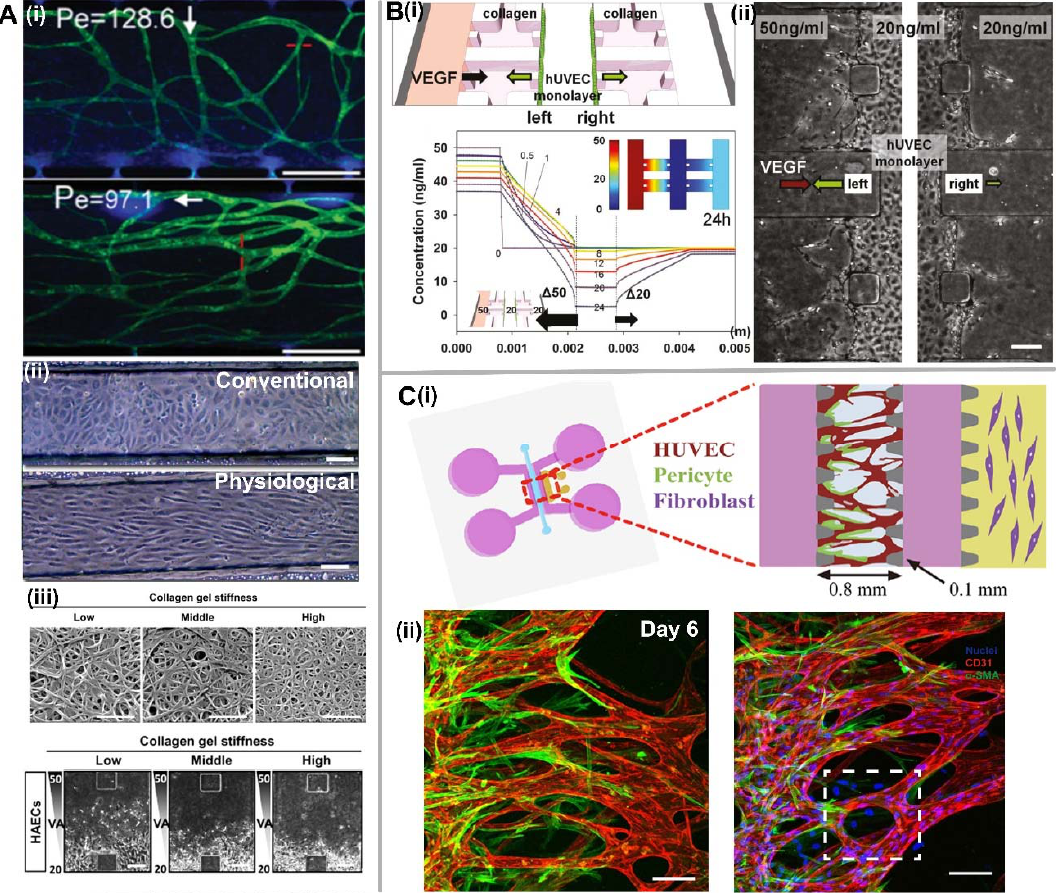
Figure 4. Three major vascular inducing factors in vascularization on chip. ( A ) Biomechanical factors. ( i ) The influence of interstitial flow with high Péclet number on vasculogenesis, and the orientation of microvascular network under the effect of interstitial flow in transverse and longitudinal directions. Scale bar, 500 μ m. Adapted by permission from Reference [40], copyright Royal Society of Chemistry 2013. ( ii ) The effect of shear stress on EC lining, and ECs were elongated and aligned with the direction of the flow under the physiological conditions compared with the conventional conditions. Scale bar, 100 μ m. Adapted by permission from Reference [57], copyright Nature Publishing Group 2014. ( iii ) The effect of gel stiffness on angiogenesis, and invasion of tubular structures into the stiff collagen gel was significantly reduced compared with the soft gel. Scale bar, 1 μ m (top) or 150 μ m (bottom). Adapted by permission from Reference [64], copyright Nature Publishing Group 2016. ( B ) Extracellular (or diffusible) signaling molecules. ( i ) Schematic of chip design where HUVECs were cultured in the center channel, and simulation result of VEGF gradient. ( ii ) Apparent sprouting angiogenesis on the left-hand side with a steeper gradient compared with the right-hand side with a gentle gradient. Scale bar, 150 μ m. Adapted by permission from Reference [50], copyright American Chemical Society 2011. ( C ) Cell source and cell-cell interactions. ( i ) Schematic of microfluidic device composed of a central vessel channel, two adjacent media channels, and the outermost fibroblast channel. ( ii ) Confocal images showing matured pericytes covered the perfusable EC network on day 6. Scale bar, 100 μ m. Adapted by permission from Reference [91], under the Creative Commons Attribution License 2015.